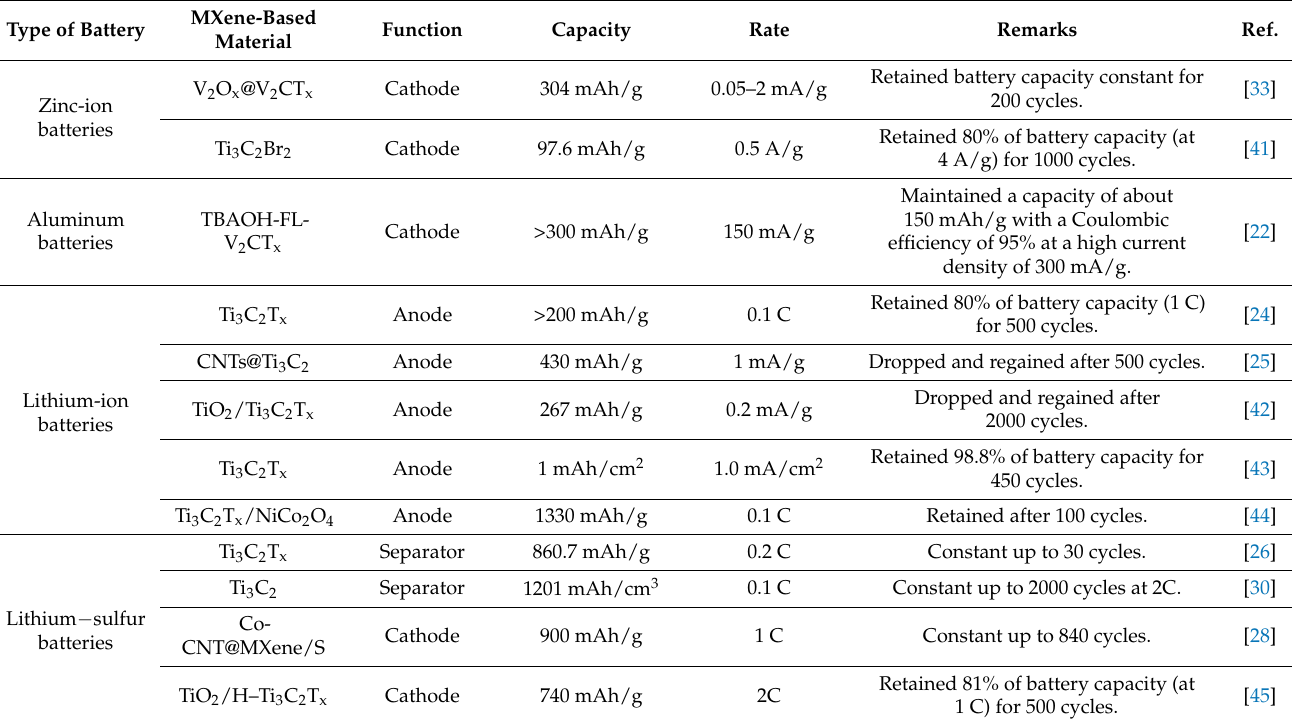
Table 1. Summary of electrochemical performance of MXene-based materials in batteries.